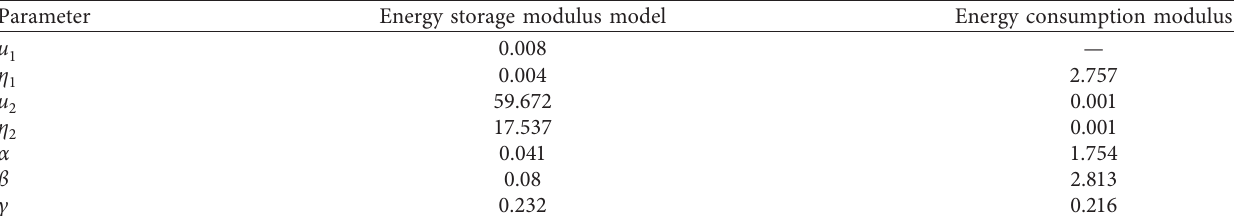
Figure 8: Comparison of fitted data and the tested data for the rubber pad: (a) modulus; (b) loss factor. Table 1: Model parameters of underrail rubber